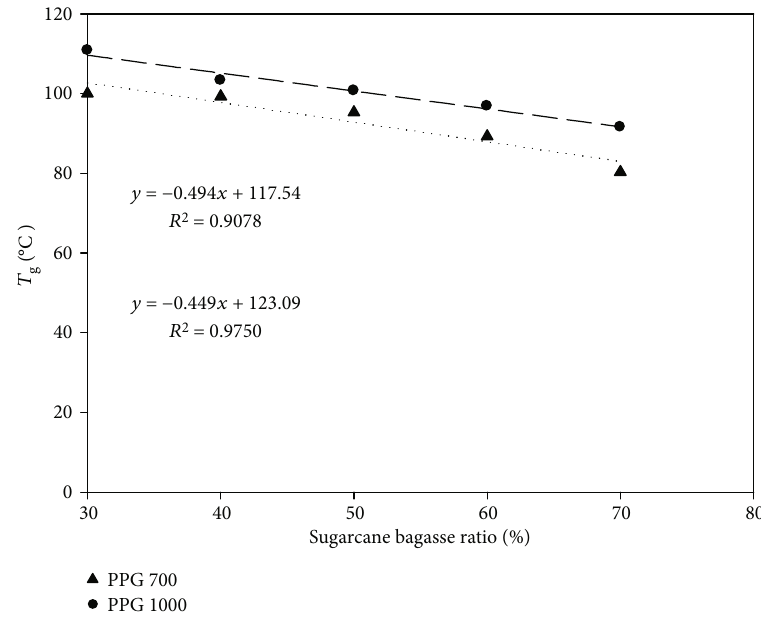
Figure 8: Linear relationship between sugarcane ratio and T